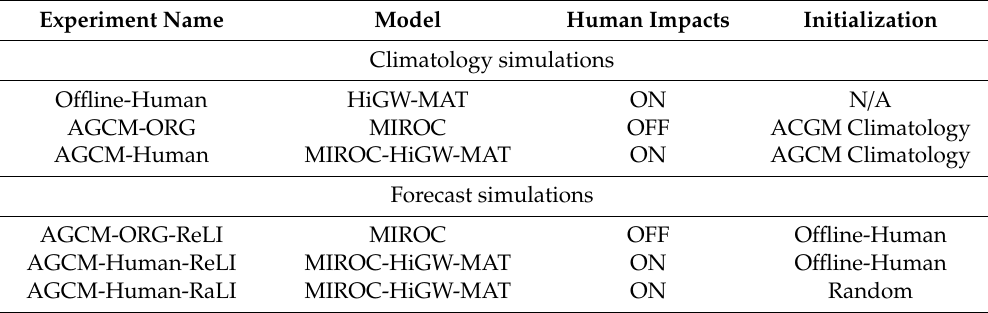
Table 1. Summary of experimental design. (HiGW-MAT: Human Impacts and Groundwater representation in the Minimal Advanced Treatment of Surface Interaction and RunO ff model; MIROC: Model for Interdisciplinary Research on Climate; AGCM-ORG: Atmospheric General Circulation Model -